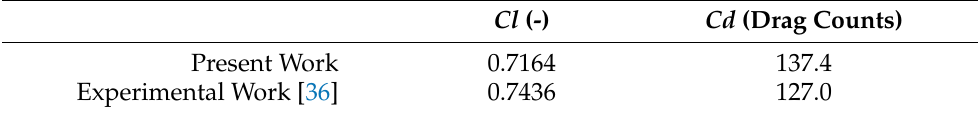
Table 2. Comparison between the numerical and the experimental results for the RAE2822 airfoil.